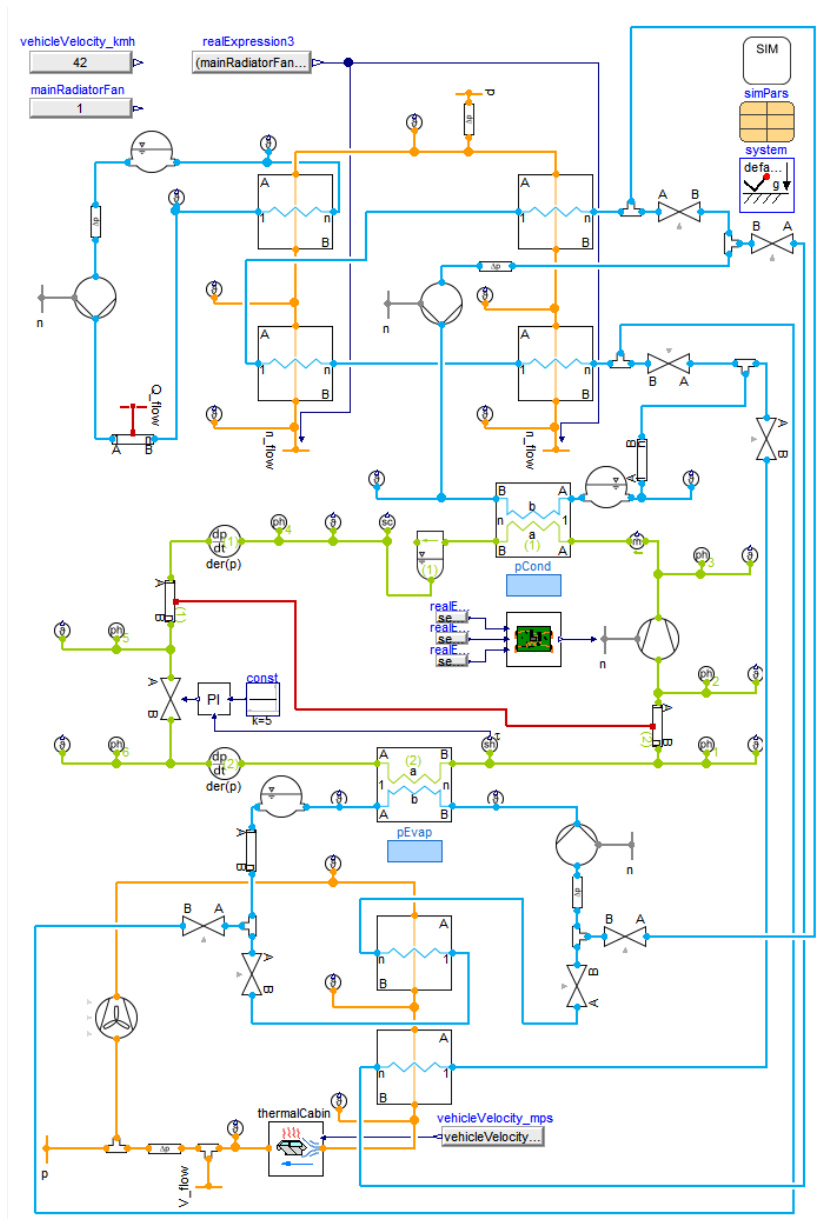
Figure 3. Implemented HVAC model in Dymola/Modelica using components from the model library TIL